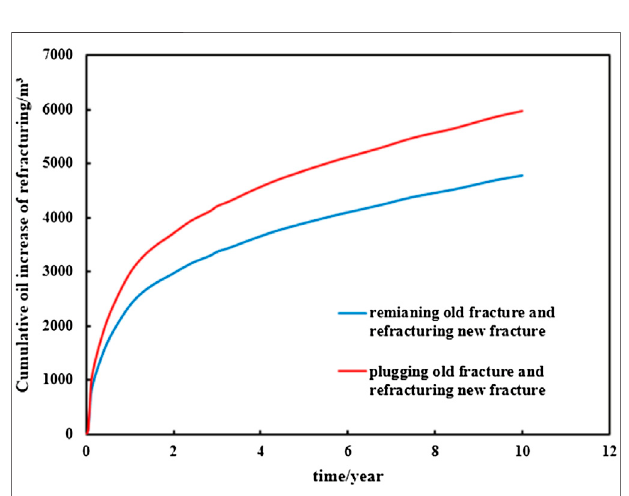
FIGURE 15 | Variation diagram of ten-year cumulative oil increase under compound pressure under different transformation modes.